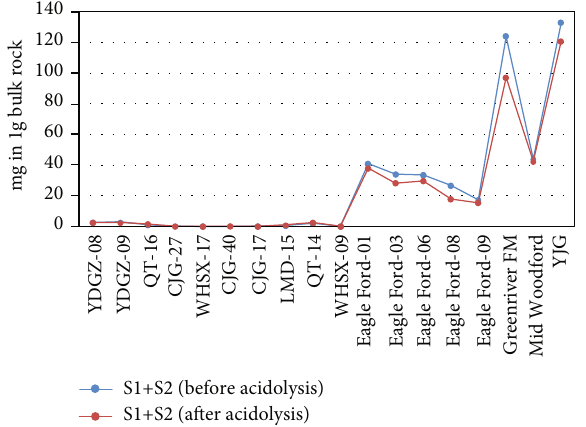
Figure 3: Comparison of S1+S2 contents for rock samples before and after treating of